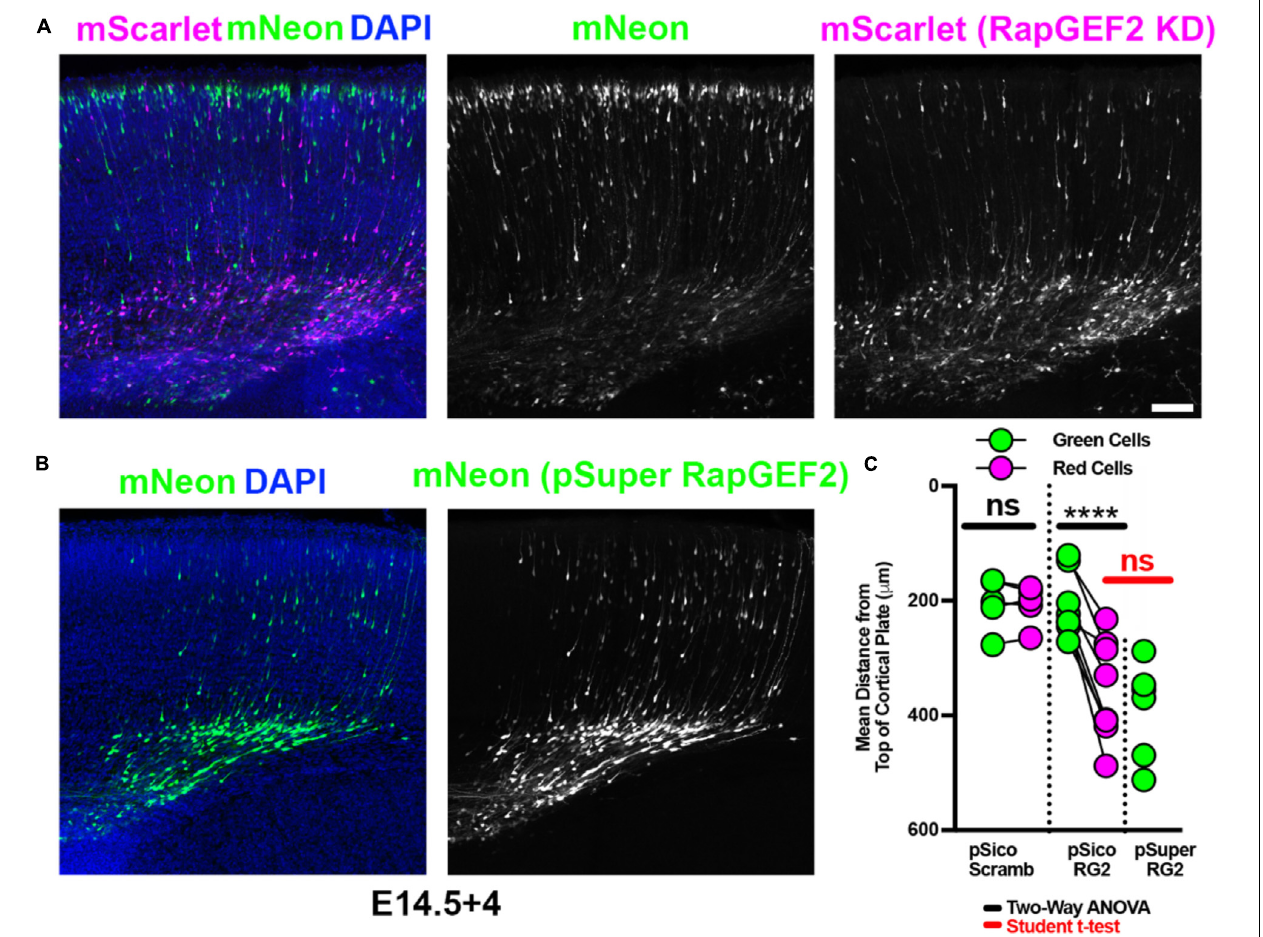
FIGURE 5 | Double UP combined with pSico provides knockdown with an internal control. Robust replication of previously discovered migration defects, utilizing Double UP and pSico. (A) Representative image of IUE with pSico RapGEF2 (2 µ g/ µ L), Double UP (1 µ g/ µ L), and pCAG-Cre (15 ng/ µ L). Scale bar: 100 µ m. (B) Representative image of IUE with pSuper RapGEF2 (2 µ g/ µ L) and Double UP (1 µ g/ µ L). (C) Dot plot of Double UP and either pSico Scrambled (pSico Scramb), pSico RapGEF2 (pSico RG2), and pSuper RapGEF2 (pSuper RG2) ( n = 5, 8, and 5 slices, respectively, each from a different brain). Each dot represents mean distance from the top of the cortical plate to all cortical neurons in a slice. Connected dots indicate measurements were made in the same brain. ns = not significant, ∗∗∗∗ p < 0.0001. Comparisons within samples (black bars) were two-way ANOVA; comparison between pSuper RapGEF2 and the red cells of pSico RapGEF2 (red bars) were performed with a Student’s t -test. Error bars not shown for clarity. See also Supplementary Figure S3